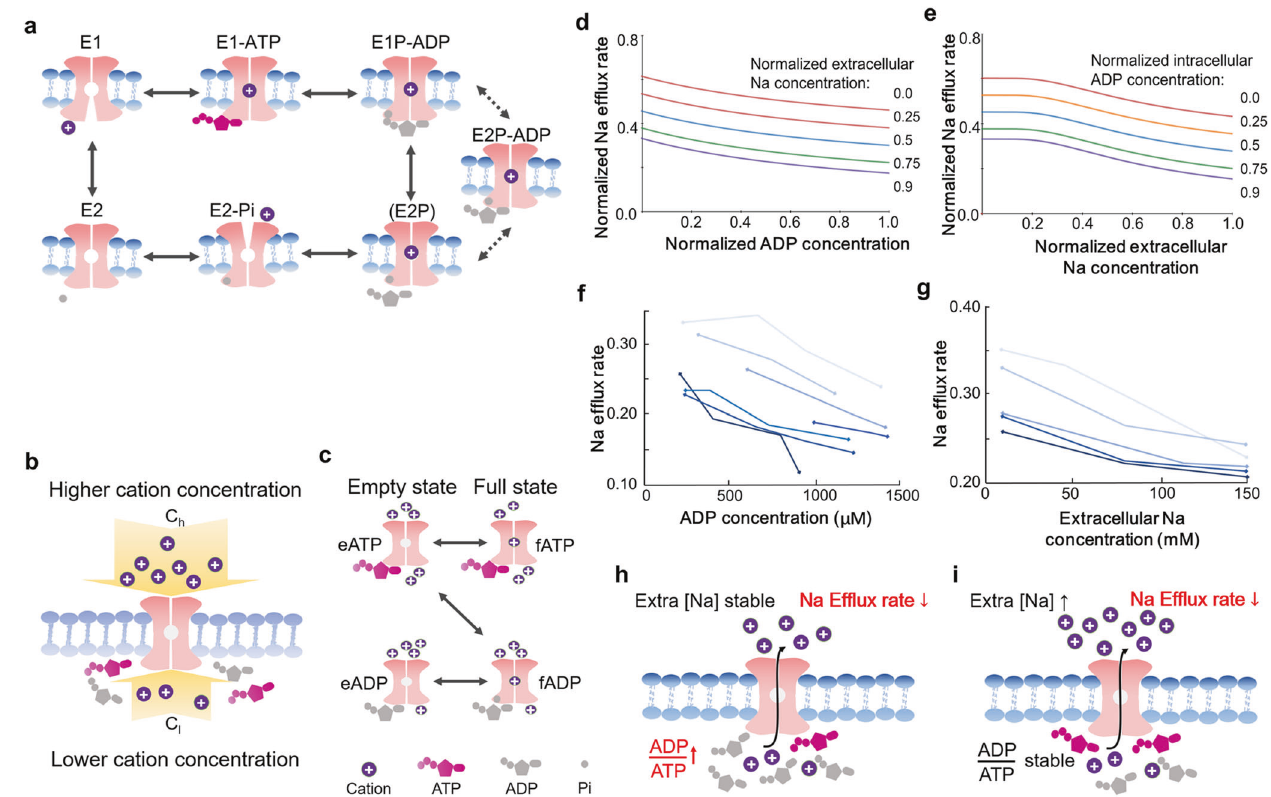
Fig. 1 Working mechanism of an active ion transport pump and Na-K exchange rate affected by the intracellular ADP or extracellular Na concentration. a Catalytic cycle of P-type ATPases exempli fi ed by a cation transport. 5 E1: high-af fi nity state for cation, E2: low-af fi nity state for cation, P: phosphorylated state. b Pump framework that can interact with nucleotides and exchange ions with either the lower- or higher- concentration side. c The pump performs intrinsic transitions mediated by the higher-concentration side (horizontal arrows). The pump and a nucleotide perform cooperative transitions eATP → fADP mediated by the lower-concentration side (diagonal arrow). d Na ef fl ux rate controlled by increasing ADP concentration at various normalized preset intracellular Na concentrations. e Decreased Na ef fl ux rate after the extracellular Na increasing at various normalized preset intracellular ADP concentrations. f The effect of various intracellular ADP levels on ouabain-sensitive Na-K exchange in resealed ghosts. g The stimulation percentage of ouabain-sensitive Na ef fl ux after external Na increasing. The phosphoarginine regenerating system was used to set and maintain ADP and ATP concentrations. See supplementary methods. h , i Illustrations of these two